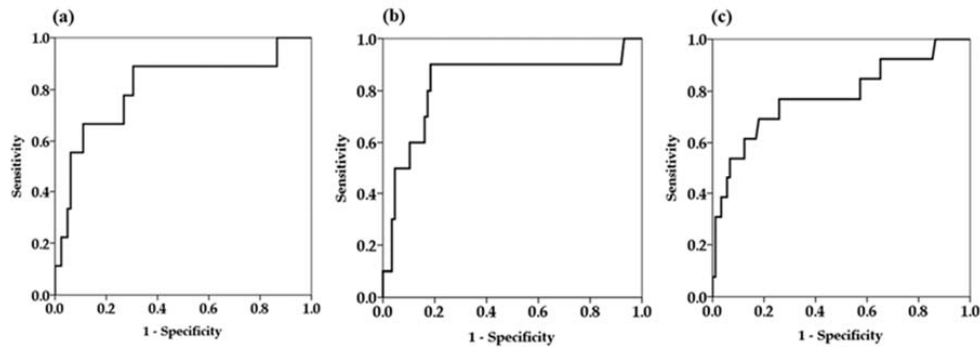
Figure 3. Receiver operator characteristics curves for prediction of hepatocellular carcinoma at di ff erent time points. ( a ) Baseline serum Mac-2-binding protein glycosylation isomer (M2BPGi) levels ( b ) serum M2BPGi levels at 48 weeks ( c ) serum M2BPGi levels at the time of last visit. Table 3. Performance of serum M2BPGi levels for predicting HCC.